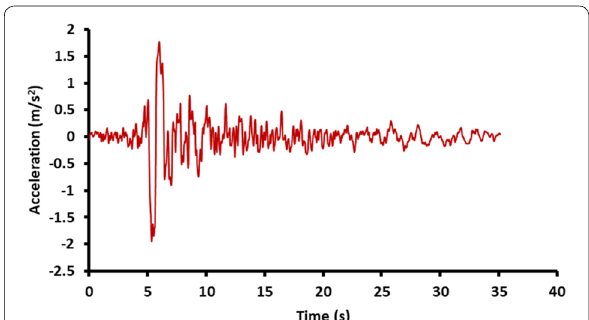
Fig. 16 Load spectrum for Romania’s 1977 Vrancea